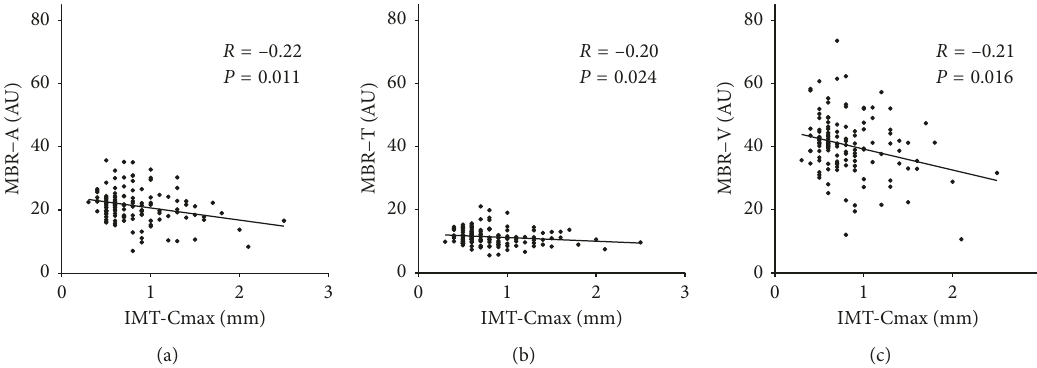
Figure 1: Relationship between IMT and MBR. (a) MBR in the overall optic nerve head was negatively correlated with IMT-Cmax ( R � − 0 . 22, P � 0 . 011). (b) MBR in the optic nerve head tissue area was negatively correlated with IMT-Cmax ( R � − 0 . 20, P � 0 . 024). (c) MBR in the optic nerve head vascular area was negatively correlated with IMT-Cmax ( R � − 0 . 21, P � 0 .